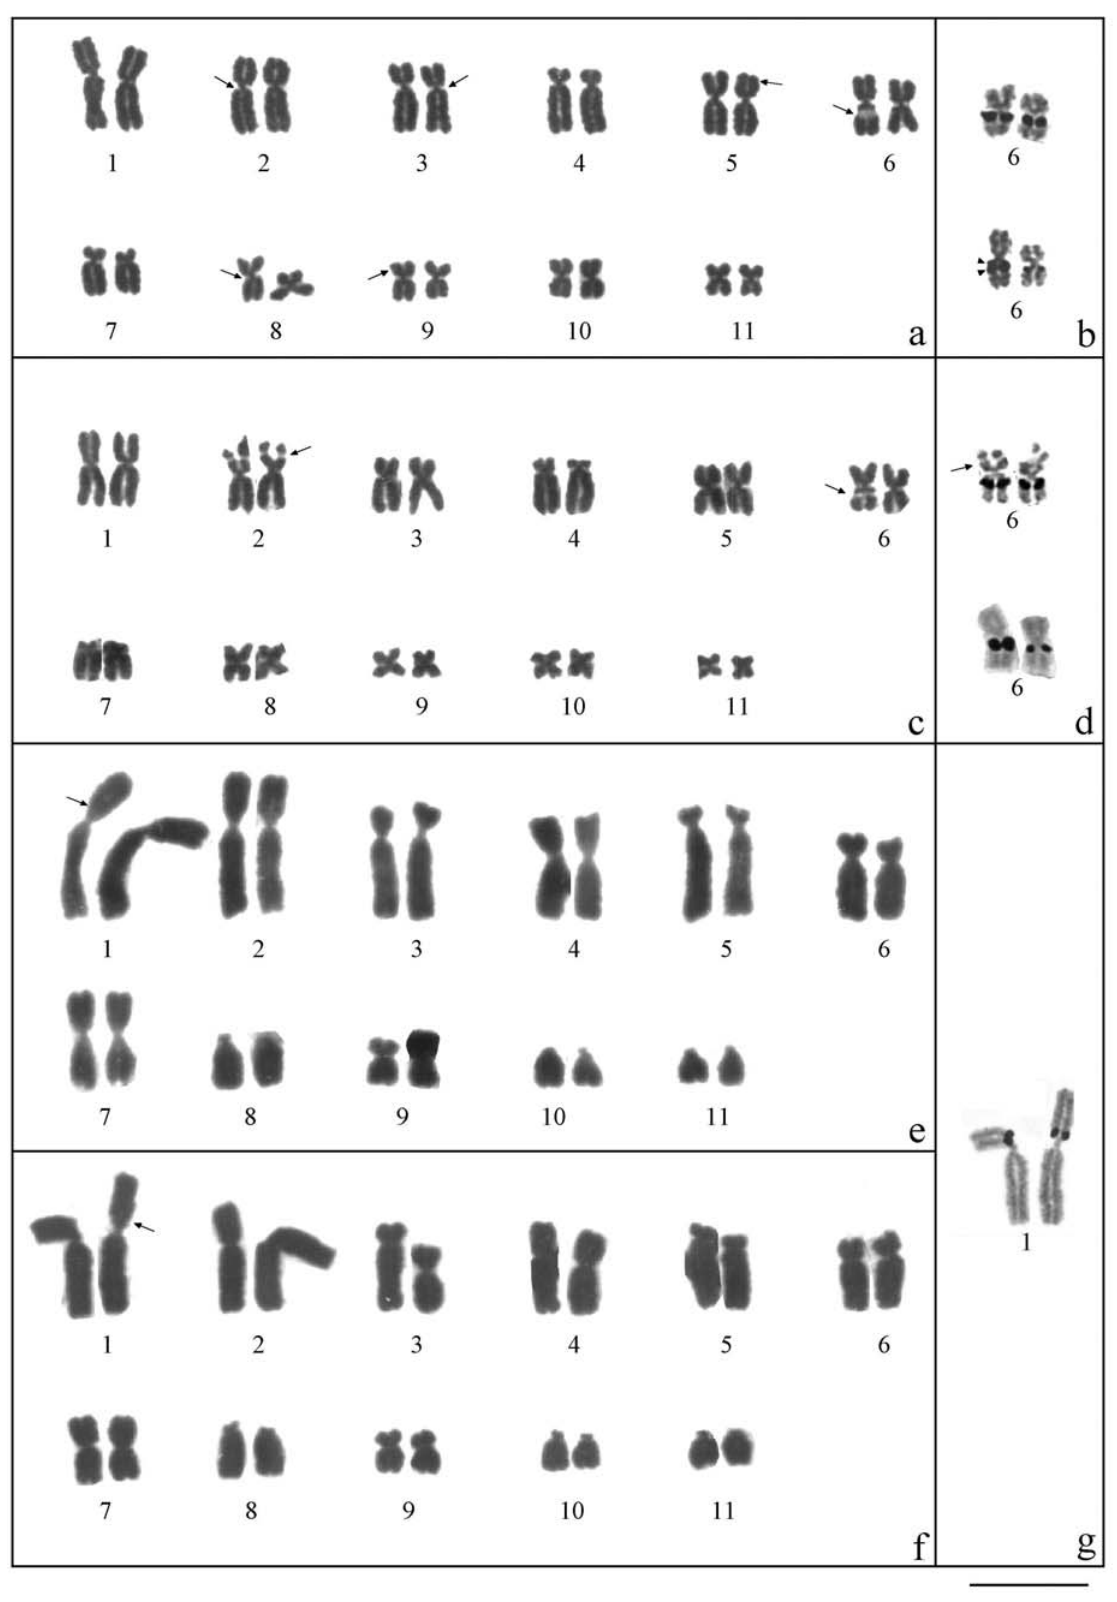
Figure 1 - Karyotypes of E. guentheri ( a ), E. parvus ( c ) and E. binotatus ( e and f ) and NOR-bearing chromosomes of each species ( b , d , and g respec- tively). The arrows indicate secondary constrictions and the arrowheads in b indicate the double blocks of NOR. Bar = 10 µ